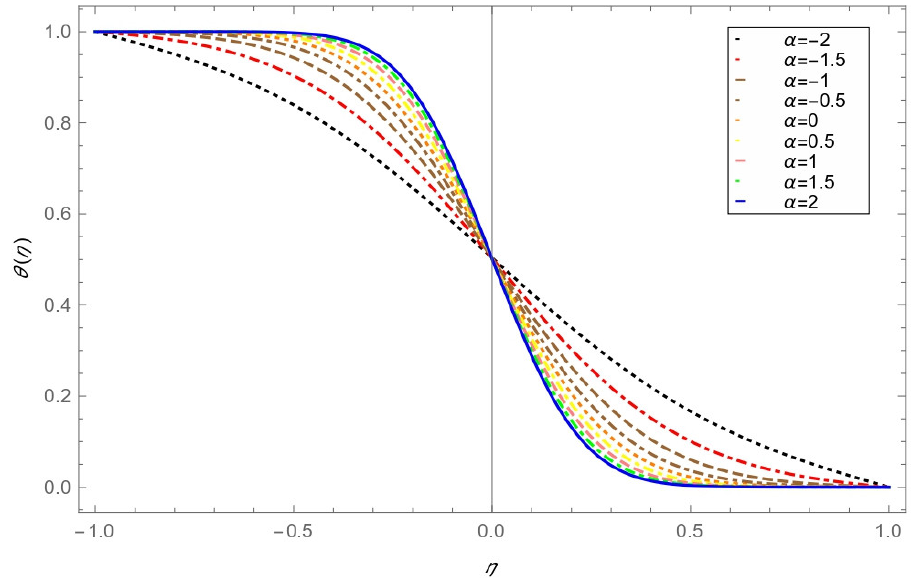
Figure 10. Temperature profile effect of the expansion ratio for = 1, = = 0.02,1 = 2 = 20, = 4.